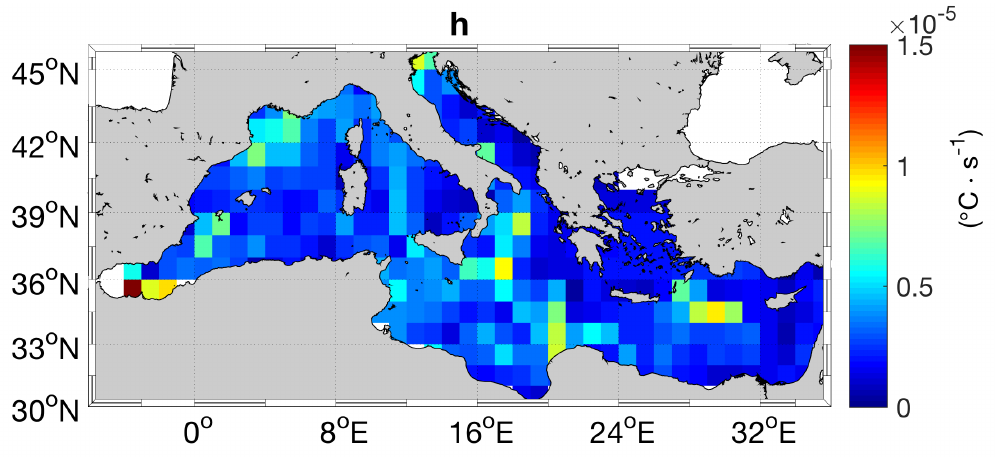
Figure 2. RMSE between F and F dri , binned on 1 ◦ × 1 ◦